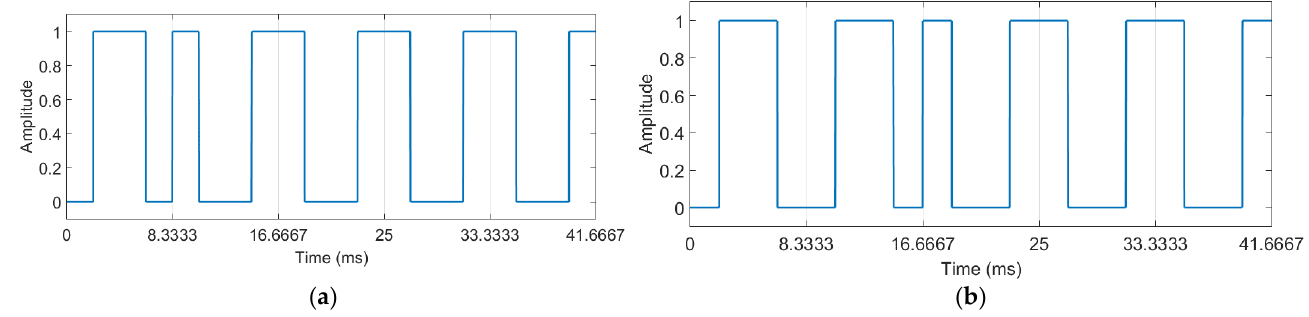
Figure 3. ( a ) The waveform for the symbol a (i.e., the binary sequence 10000). ( b ) The waveform for the symbol b (i.e., the binary sequence 11000).